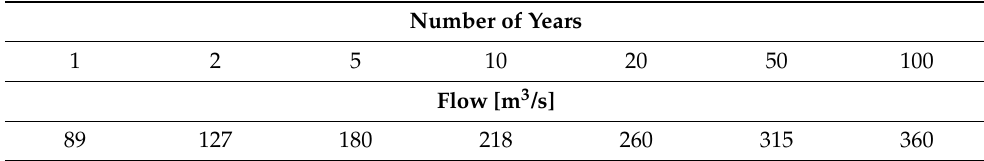
Table 5. The N-year maximum discharges of the Torysa river in the Kosicke Olsany hydrological station